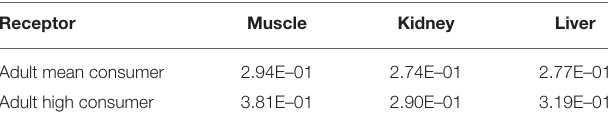
TABLE 7 | HQ values for TEQ in moose tissue including background exposure for the adult receptor (ND =